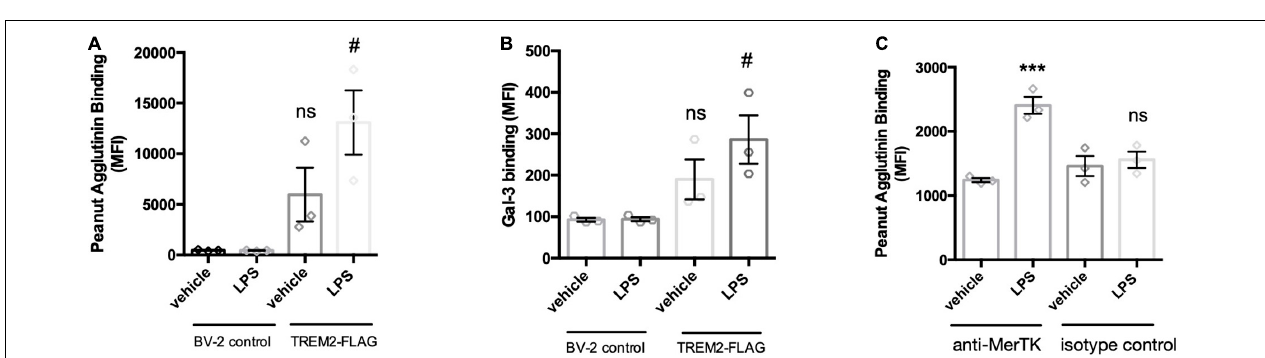
FIGURE 5 | Neu1 regulates microglial phagocytosis. Phagocytosis of 5 µ m beads by BV-2 microglia as measured by flow cytometry. (A) Assessment of bead uptake 3 h after treatment with sialidase (200 mU/ml). Heat-inactivated sialidase was included as a control. Data presented as mean uptake measured in 3 independent experiments with error bars representing S.E.M. Statistical analysis was performed by one-way ANOVA followed by Tukey’s post hoc , ** p < 0.01, ns: non-significant. (B) Phagocytosis was assayed 48 h post non-targeting (si-NT) or Neu1-targeting (si-Neu1) siRNA transfection. Data presented as mean uptake measured in 4 independent experiments with error bars representing S.E.M. Statistical analysis was performed by unpaired t-test, * p < 0.05. (C) Phagocytic capacity of lentiviral transduced, Neu1-overexpressing cells was assessed. Data presented as individual uptake measurements from 3 independent experiments. Statistical analysis was performed by paired (B) t -tests, ** p < 0.01.